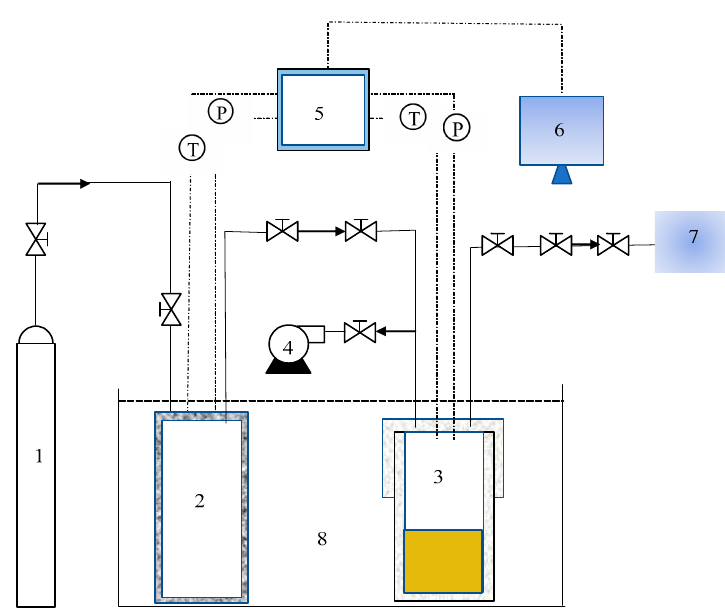
Figure 1. Schematic diagram of hydrate formation experimental reaction device. 1. Gas cylinder, 2. buffer tank, 3. high-pressure reactor vessel, 4. vacuum pump, 5. data acquisition system, 6. computer, 7. gas chromatograph, and 8. thermostatic bath.